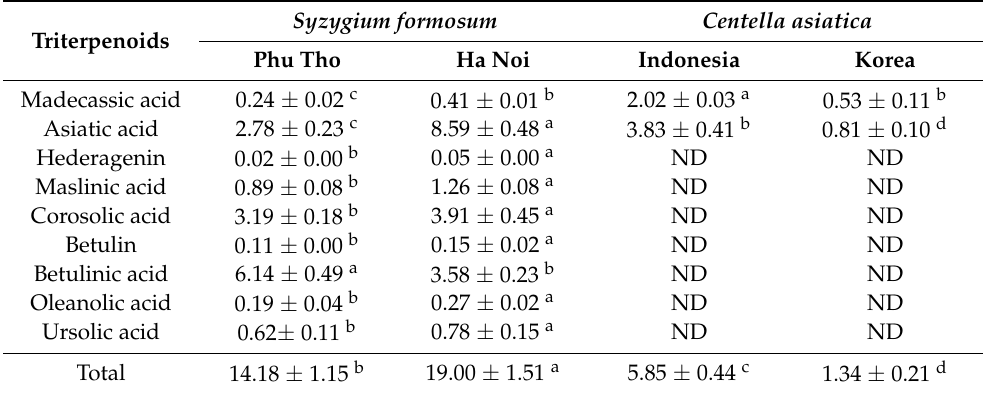
Table 4. Triterpenoid contents (mg/g dry leaf) in Syzygium formosum and Centella asiatica leaves. Syzygium formosum Centella Triterpenoids